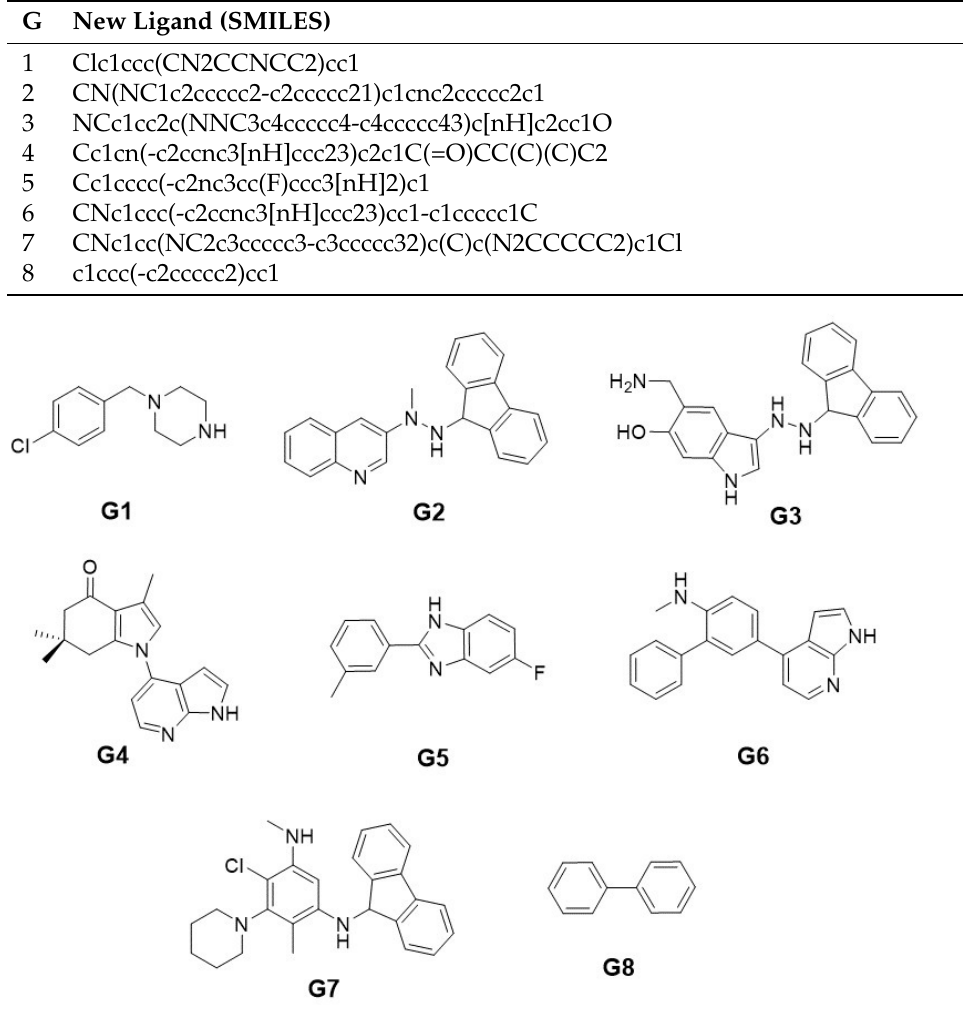
Figure 9. New ligand structures with the best binding energy obtained with the heuristic search approach for each